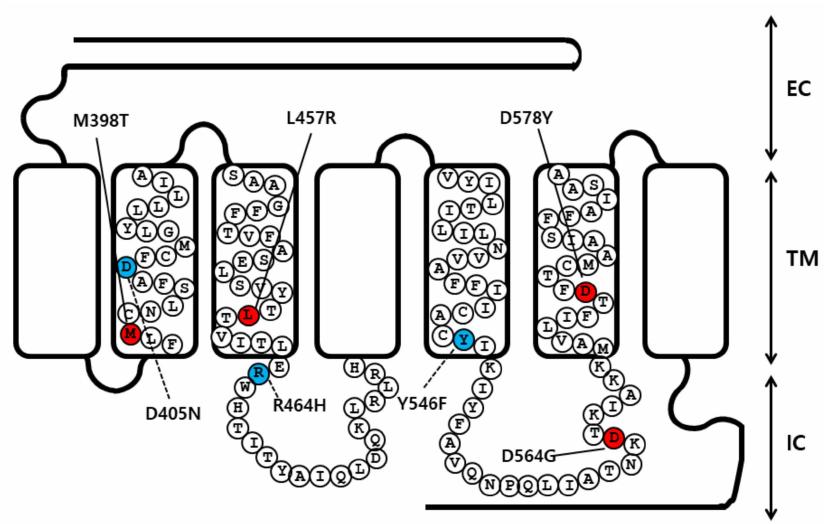
Figure 1. Schematic representation of the structure of eLH/CGR. The locations of the constitutive activating mutations (M398T, L457R, D564G, and D578Y) and the three inactivating mutations (D405N, R464H, and Y546F) are indicated. The red circle indicates the constitutively activating mutations, and the green circles indicate inactivating mutations. EC, extracellular domain; TM, transmembrane domain; IC, intracellular